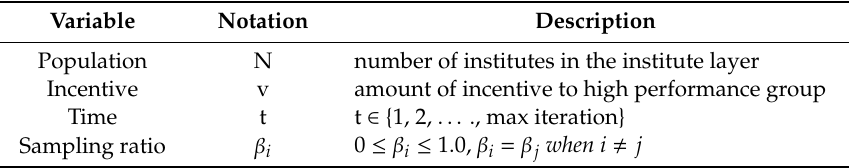
Table 3. The list of attributes in the system